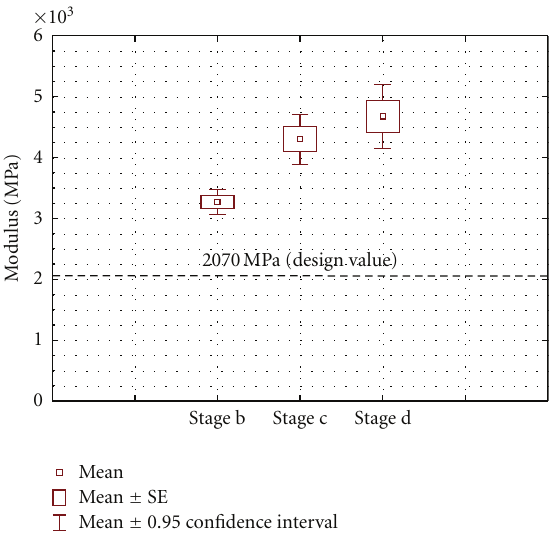
Figure 15: Composite moduli of pavement at each stage.